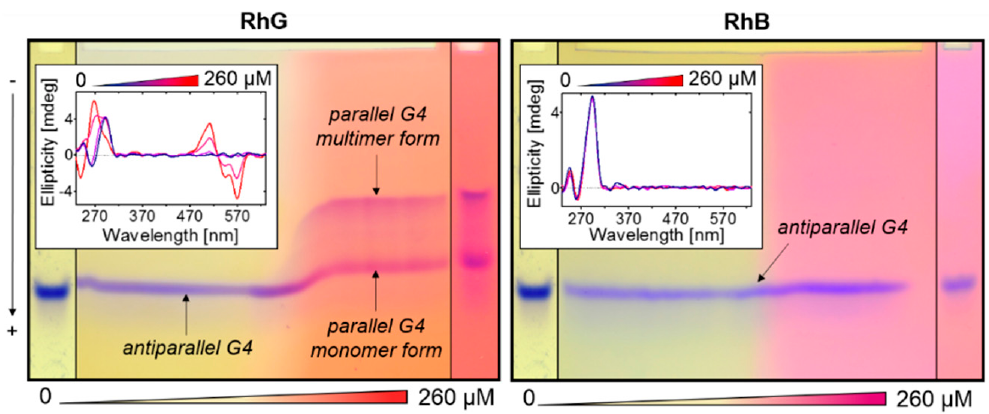
Figure 7. LGGE of HIV-M27 (d-[GTGGCCTGGGCGGGACTTGGGA]) performed in a 25 mM mRB buffer, pH 7.0 supplemented with 50 mM KCl and 0 to 260 µM rhodamines RhG ( left ) and RhB right ). The concentration of polyacrylamide was 12%. The inset represents a corresponding CD spectrum under the same conditions. The concentration of ligand in CD was 0–260 µM, the increment is 65 µM. The G4 conversion from antiparallel to parallel monomer and dimer is highlighted with arrows. The left and right columns represent standard PAGE of HIV-M27 performed in gels containing 0 and 260 µM of ligands, respectively.